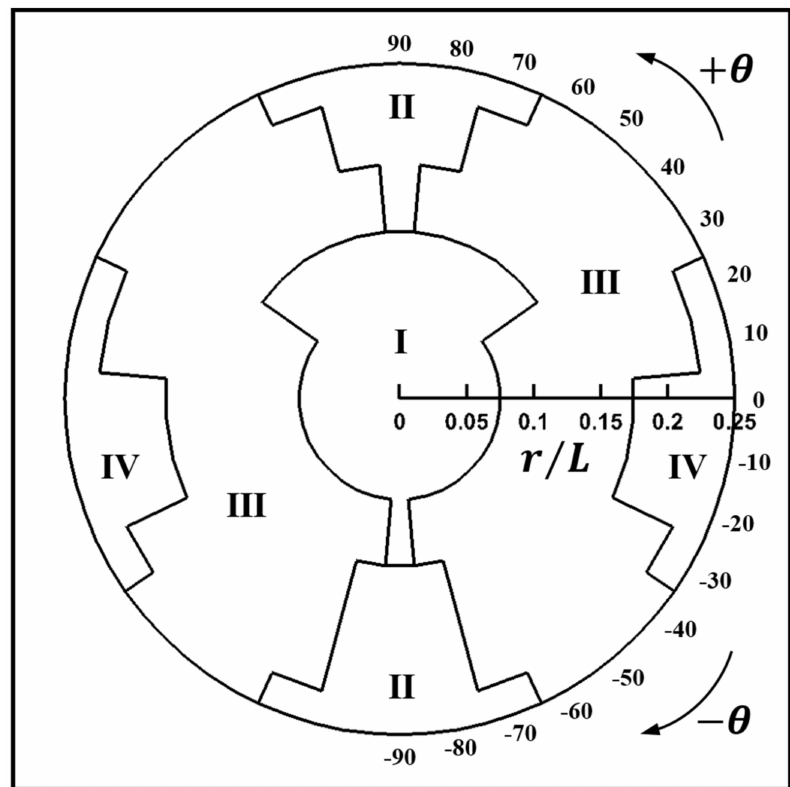
Figure 9. Map of the flow structure for Ra = 10 4 .